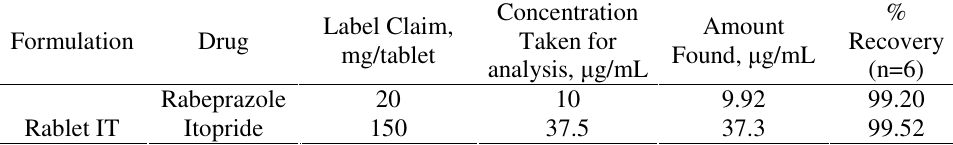
Figure 3. Chromatogram of tablet solution Table 3. Analysis of